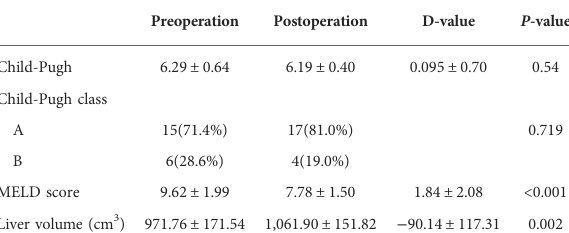
TABLE 6 Liver function improvements and liver volume increasement ( n